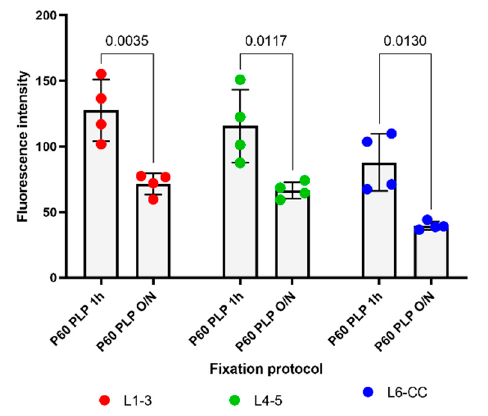
Figure 4. The effects of different lengths of PLP fixation on the intensity of PDGFR α immunofluo- rescence at P60 in different layers. Left: PDGFR α immunofluorescence intensity in L1–3 after PLP 1 h and PLP O/N. Middle: PDGFR α immunofluorescence intensity in L4–5 after PLP 1 h and PLP O/N. Right: PDGFR α immunofluorescence intensity in L6-CC after PLP 1 h and PLP O/N. A 2-way ANOVA followed by Tukey’s multiple comparisons test n = 4 for each group. Comparison among fixatives: F(1, 18) = 49.48, p < 0.0001. Comparison among layers: F(2, 18) = 8.791, p = 0.0022.